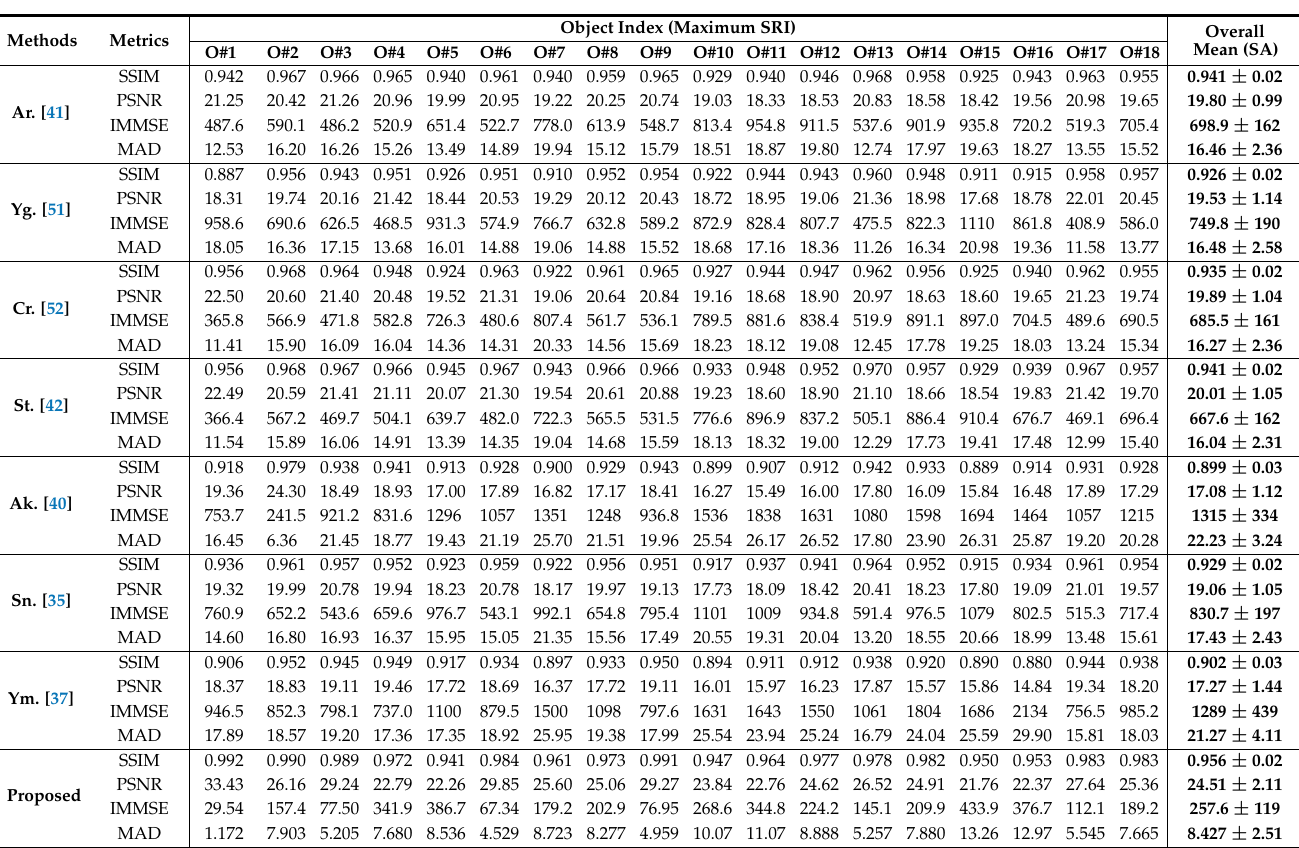
Table 2. Performance evaluations of different methods using different SRI metrics for 18 objects (O#1–O#18) and overall mean (all sub-aperture images in 4D LF) in MSPLFI object